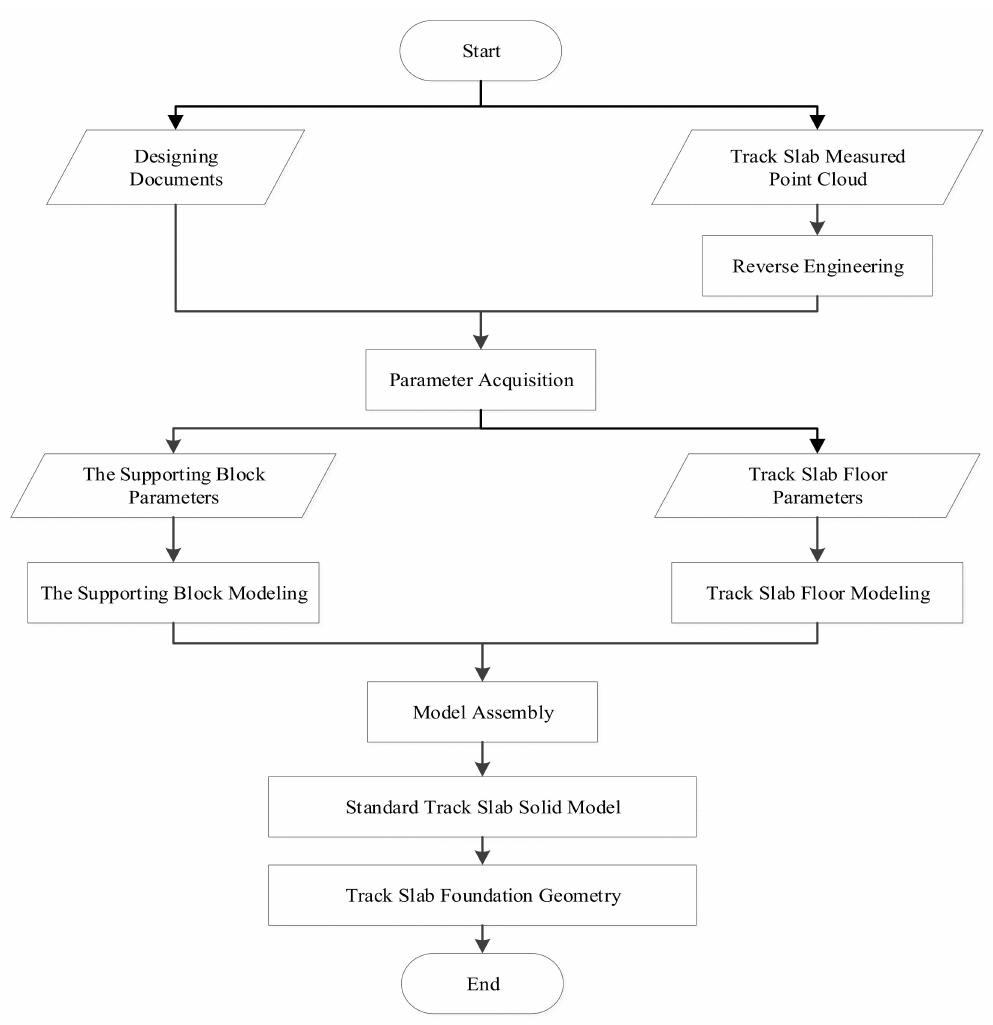
Figure 2. Track slab solid modeling